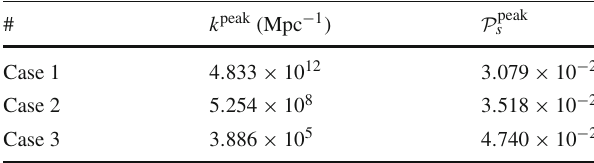
Table 3 The comoving wavenumber and amplitude of the peak of the scalar power spectrum for Case 1, 2, and